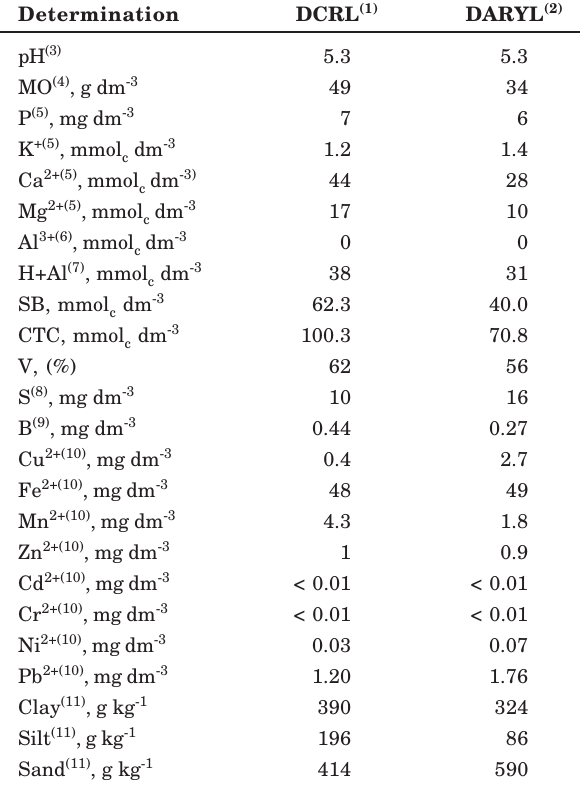
Table 2. Soils chemical and physical properties after liming in experiment with Zn sources to